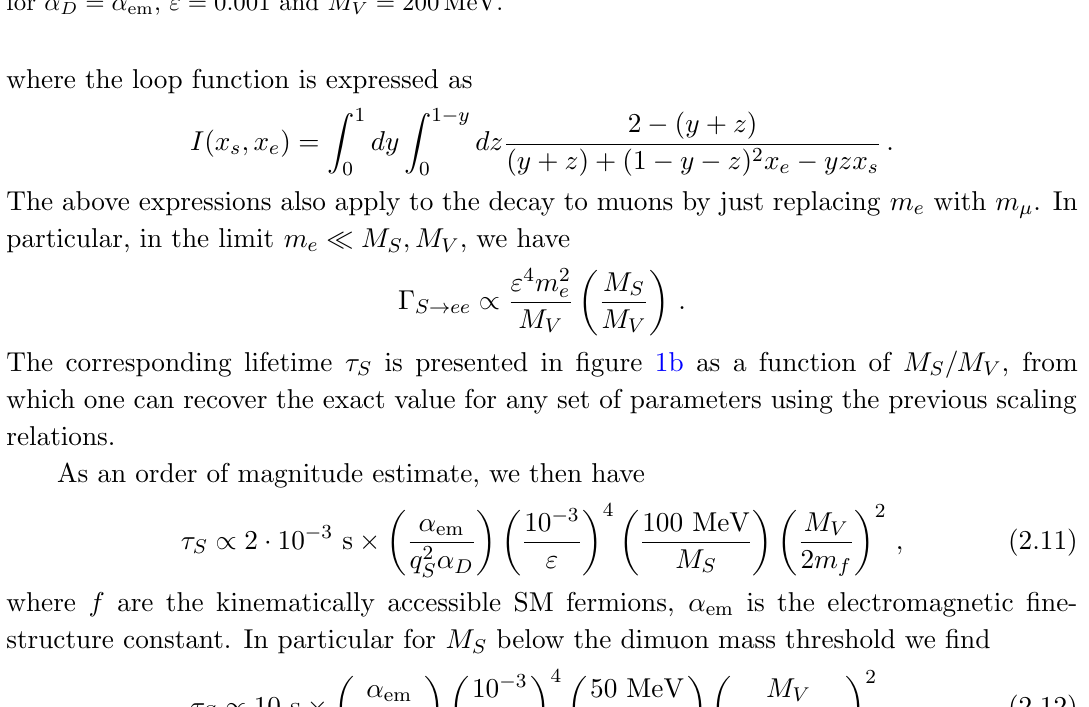
Figure 1. (a) Loop diagram for the dark Higgs boson decay with f denoting an SM fermion whose coupling to V is " -suppressed. (b) Dark Higgs lifetime in seconds as a function of the ratio M S =M V for (cid:11) D = (cid:11) em , " = 0 : 001 and M V = 200